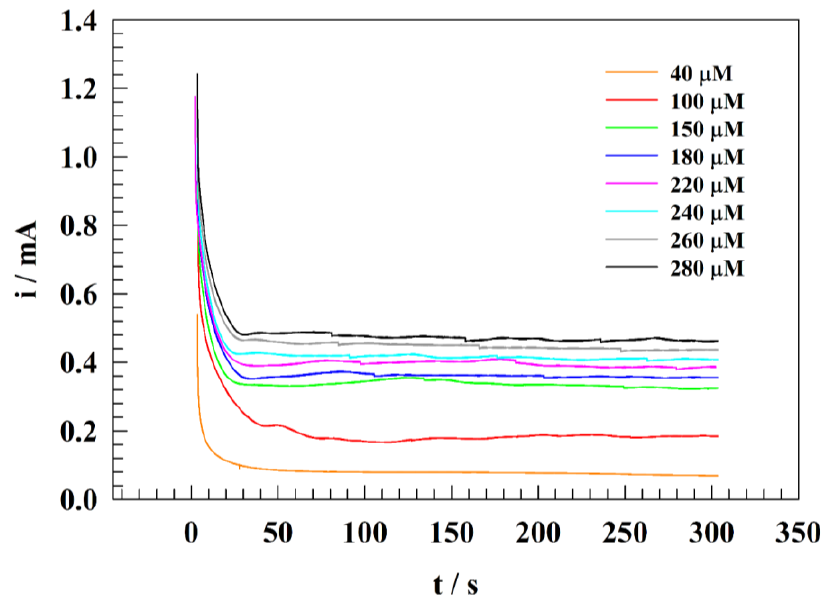
15 of 19 Figure 10. ( a ) Chronoamperogram of the modified GC/PANI/NiOnF electrode in the existence of different interfering ions. ( b ) CVs of GC/PANI/NiOnF in the presence and absence of interfering species. 3.7. Real Sample Measurement We studied nitrite detection in distilled and drinking (tap) water. In contrast, the wa- ter sample, including brackish and surface water, contained several contaminants which affected the detection steps, such as microorganisms, organic compounds, and contami- nants. The water sample was diluted with PBS, and the pH was adjusted to approximately